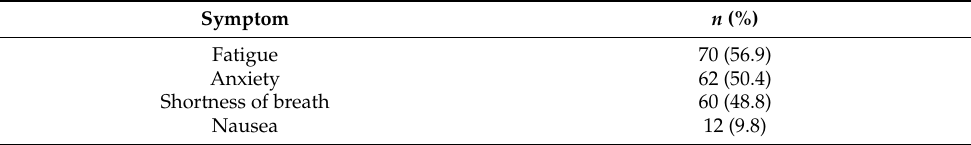
Table 2. Most common moderate-to-severe symptoms at baseline.